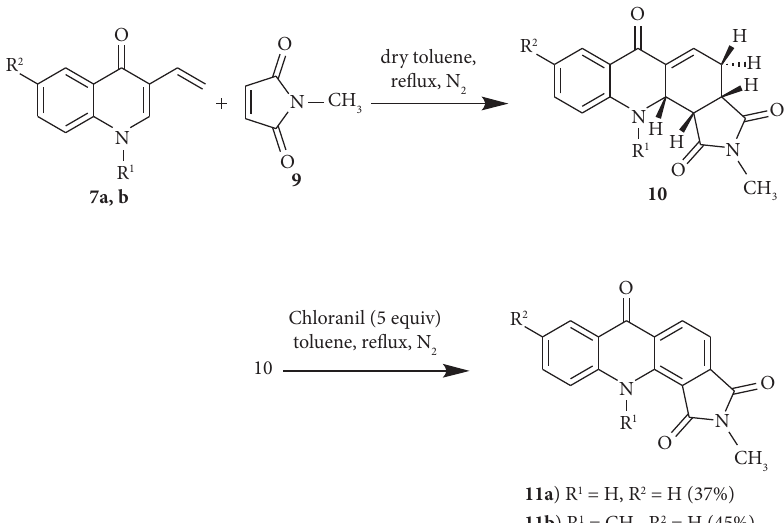
Scheme 3: Diels–Alder reaction of 3-vinyl-4-quinolones 7a , b with N- methylmaleimide 9 to give novel acridones 11a , b .